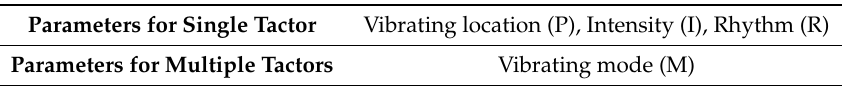
Table 2. Coding parameters for tactors.